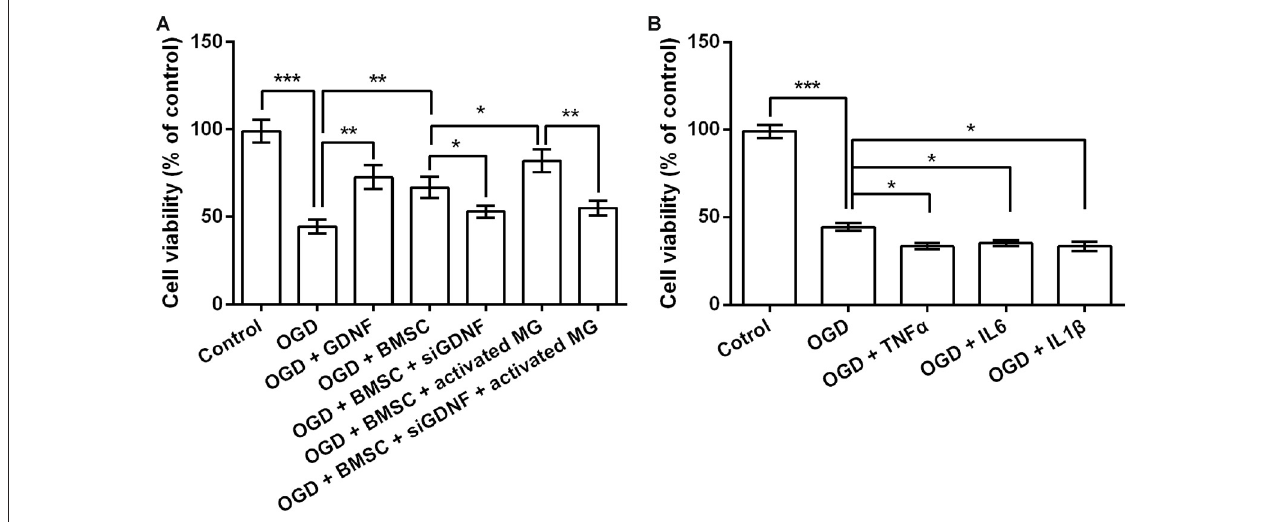
FIGURE 3 | GDNF repairs OGD-induced neuronal injury. (A) Neuronal viability is promoted by pretreatment with GDNF after OGD, and is inhibited by GDNF-specific siRNA transfection. (B) TNF α , IL6 or IL1 β suppresses neuronal viability. ∗ P < 0.05. ∗∗ P < 0.01. ∗∗∗ P < 0.001.